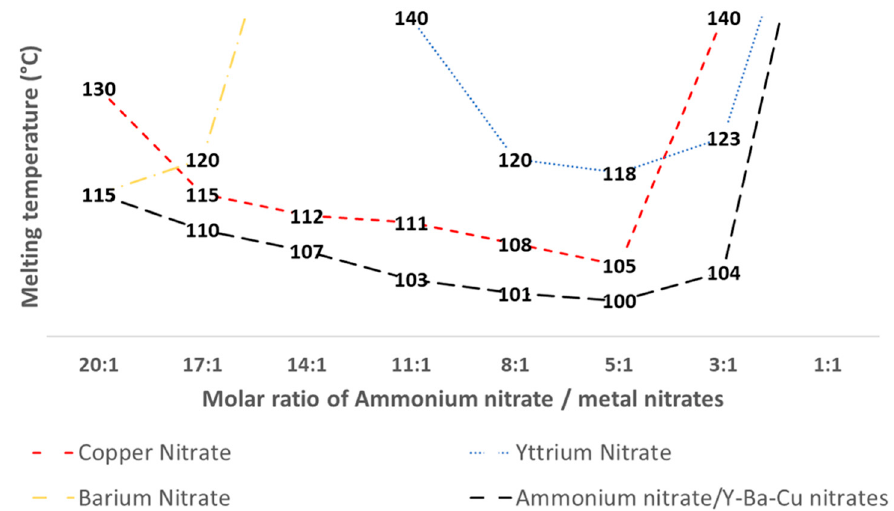
Figure 1. Phase diagram showing the eutectic behavior of the metal nitrates when mixed with ammonium nitrate in different molar